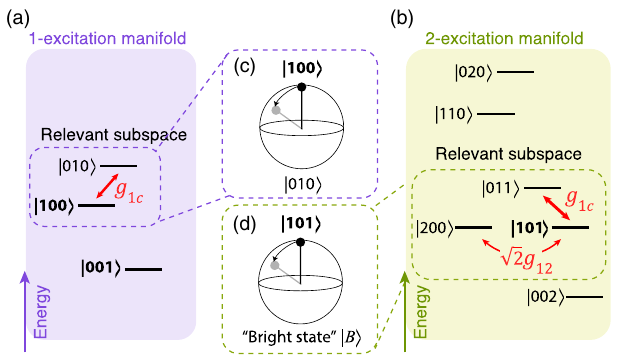
FIG. 3. (a),(b) Energy level diagrams of the single- and double- excitation manifolds. The dashed boxes indicate subspaces spanned by energy levels that are relevant to coherent leakage during the CZ gate. The red double-headed arrows denote exchange interactions between the energy levels. (c) Bloch-sphere representation of the relevant subspace in the single-excitation manifold. (d) Bloch-sphere representation of the two-level approximation for the relevant subspace in the double-excitation ≫ g manifold. When g 1 12 , and because the transition between c j 200 i and j 011 i is dipole forbidden, the state j 101 i primarily interacts with a bright state j B i ≡ cos Θ j 011 i þ sin Θ j 200 i , ffiffiffi 2 p g 12 =g 1 where Θ ≡ tan − 1 ð c Þ